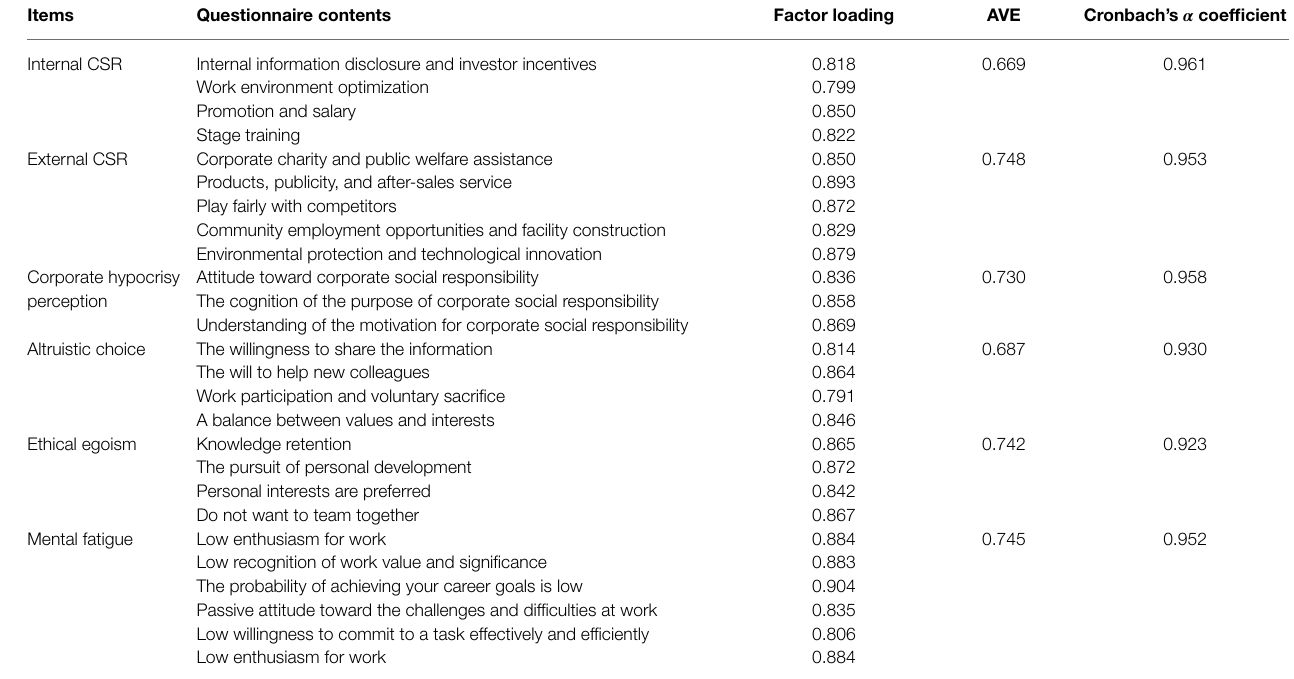
TABLE 2 | Reliability statistics for each variable of the research model.